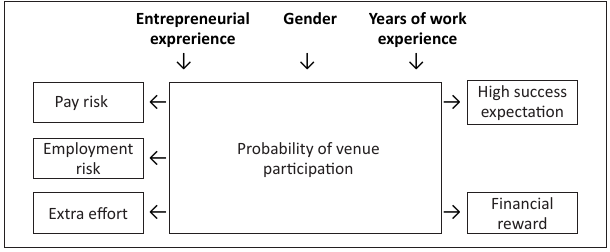
FIGURE 1: Proposed attributes that influence employee participation in corporate entrepreneurship